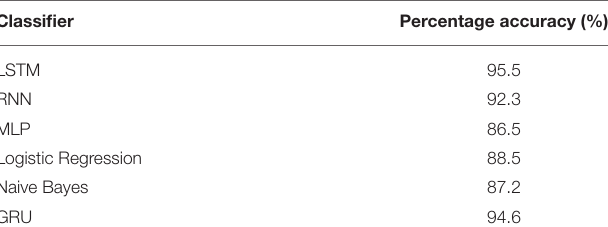
TABLE 4 | Performance of training score accuracy for selected classifiers.